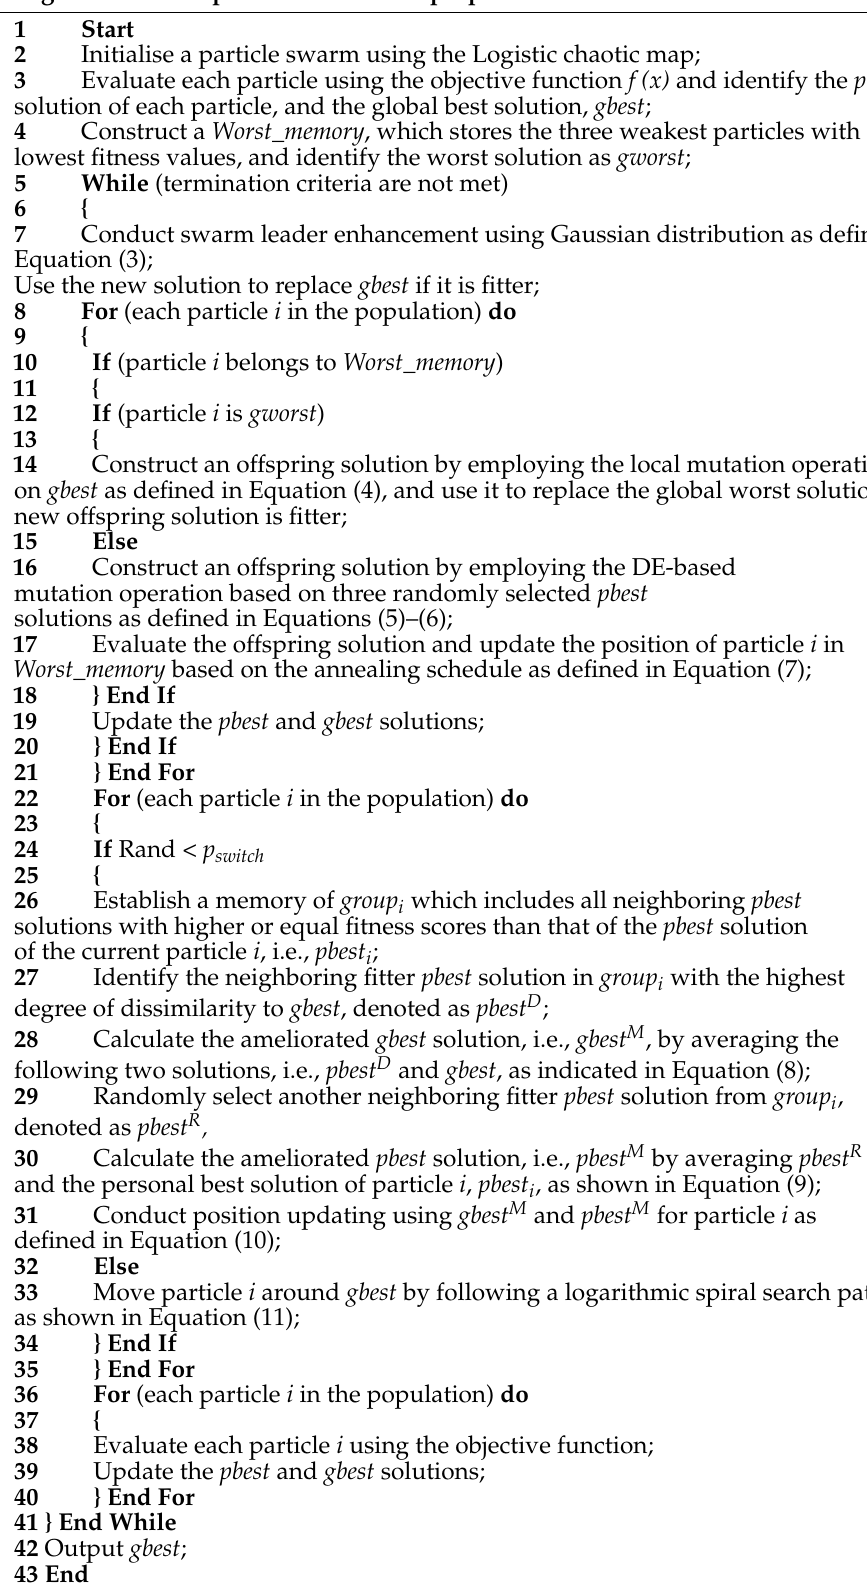
Algorithm 1. The pseudo-code of the proposed PSOVA1